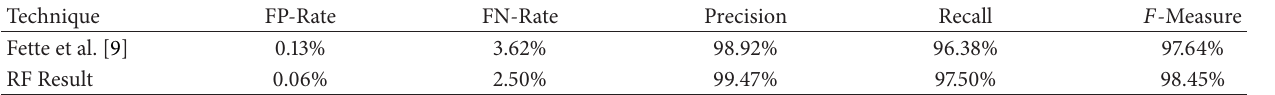
Table 3: Classification Result for Random Forest ML on the best eight features.